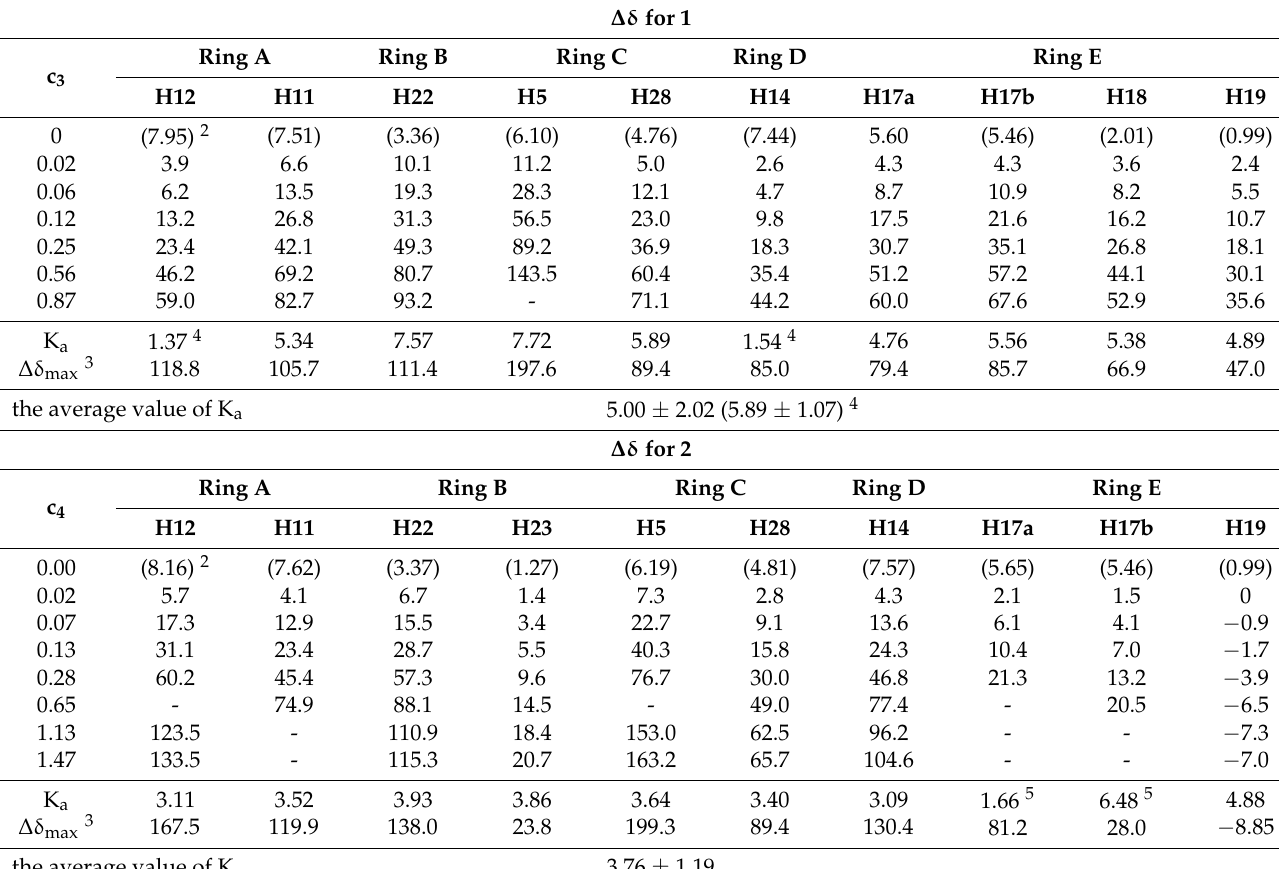
Table 4. The chemical shift changes, ∆ δ 1 [Hz], of proton signals of 1 or 2 in D 2 O buffer, pH 6.0 (25 mM NaCl/25 mM K 3 PO 4 ), induced by interaction with octamer 3 in solutions of different concentrations of octamer 3 , c 3 [mM], and a constant concentration of 1 or 2, c 1 = c 2 = 0.29 mM, temp. 10 ◦ C. The binding constants, K a [mM − 1 ], were calculated based on chemical shift